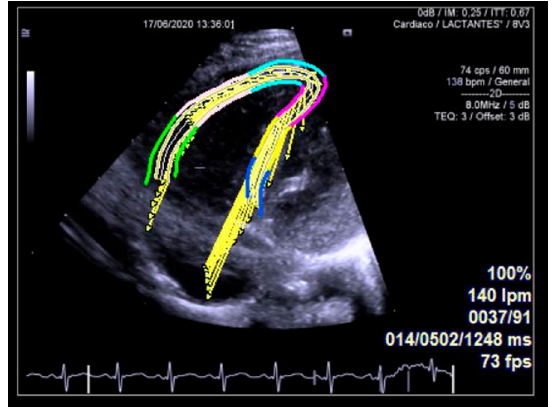
Fig. 1 Right ventricle‑focused four chamber view. Strain analysis of right ventricle with speckle tracking software. The endocardial and epicardial borders were manually delineated to perform a semiautomatic trace of the myocardial movement. The magnitude and direction of each vector reflect the corresponding myocardial movement towards the reference